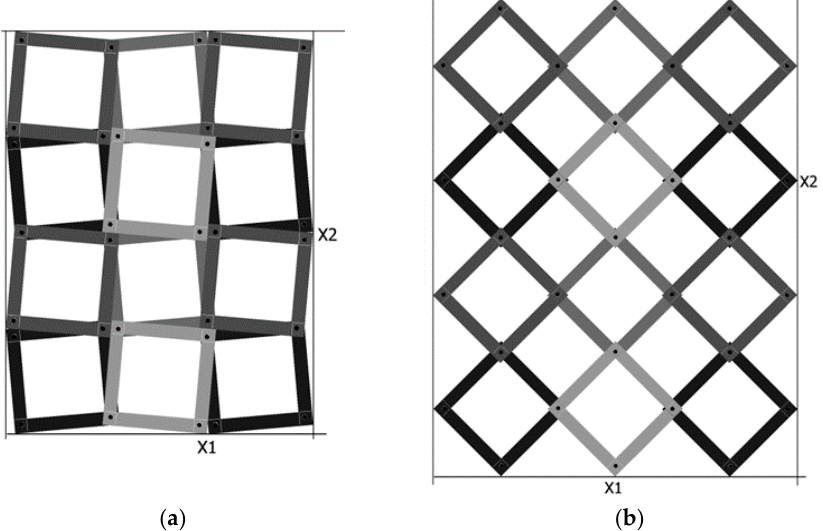
Figure 3. Auxetic structures made of rigid rotating square frames in the closed position ( a ) and in the open position ( b ).